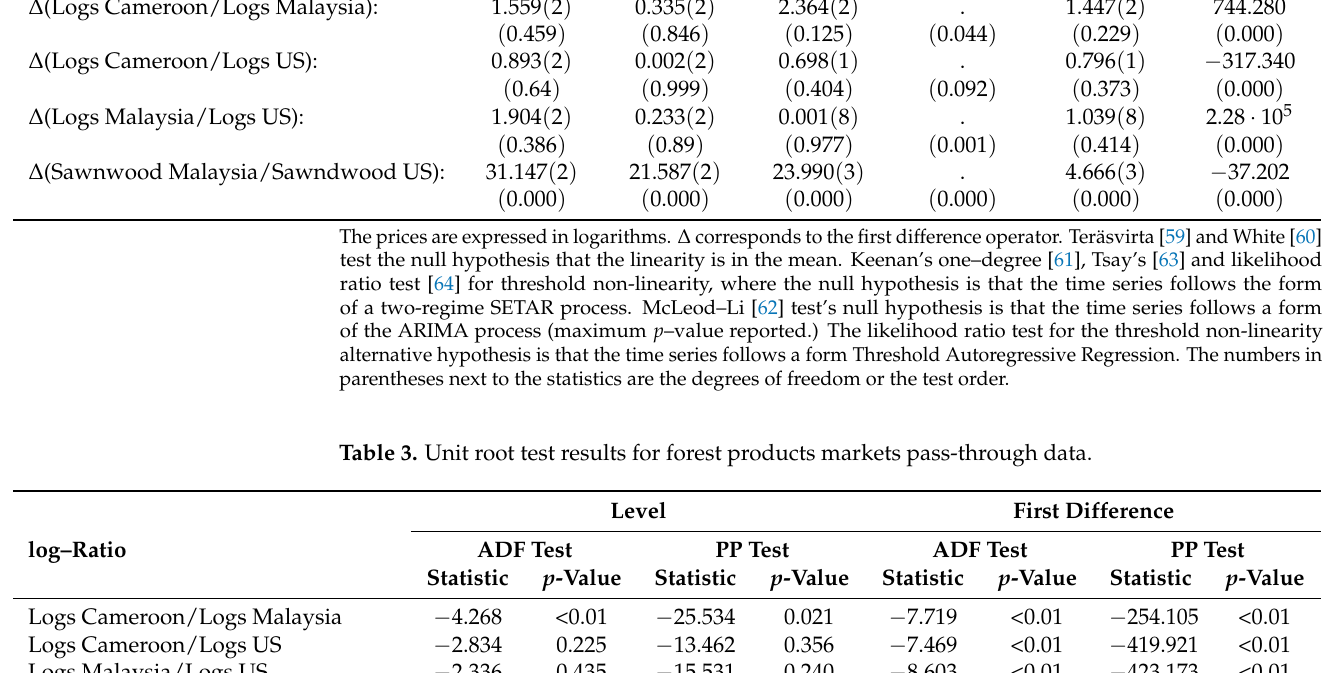
Table 2. Non-linearity tests for price ratios in first difference. Teräsvirta White Keenan